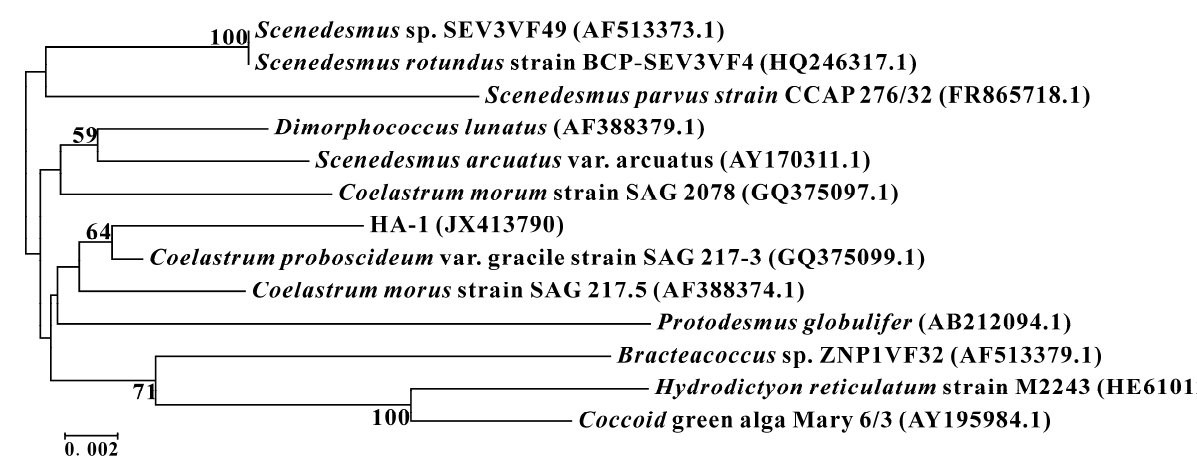
Figure 1. Dendrogram inferred from 18S rDNA gene sequences of strain